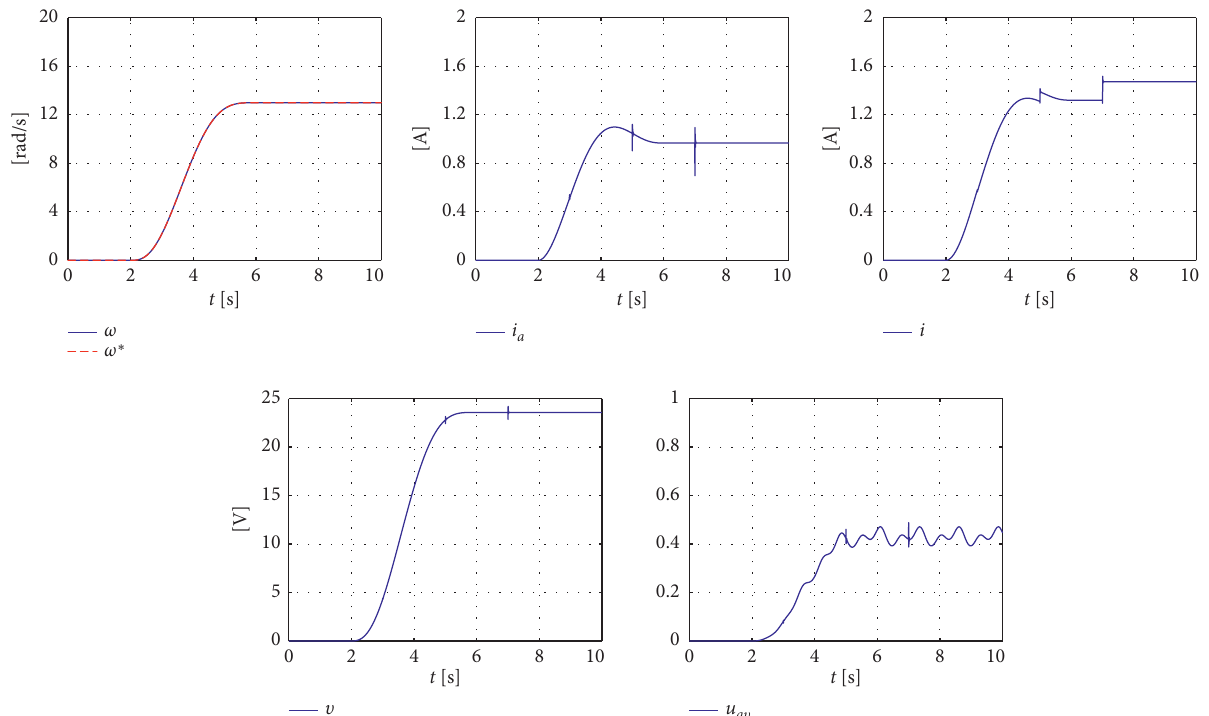
Figure 4: DC/DC Buck converter-DC motor system response when the time-variant waveform and abrupt variations are defined by equations (17) and (21), respectively.